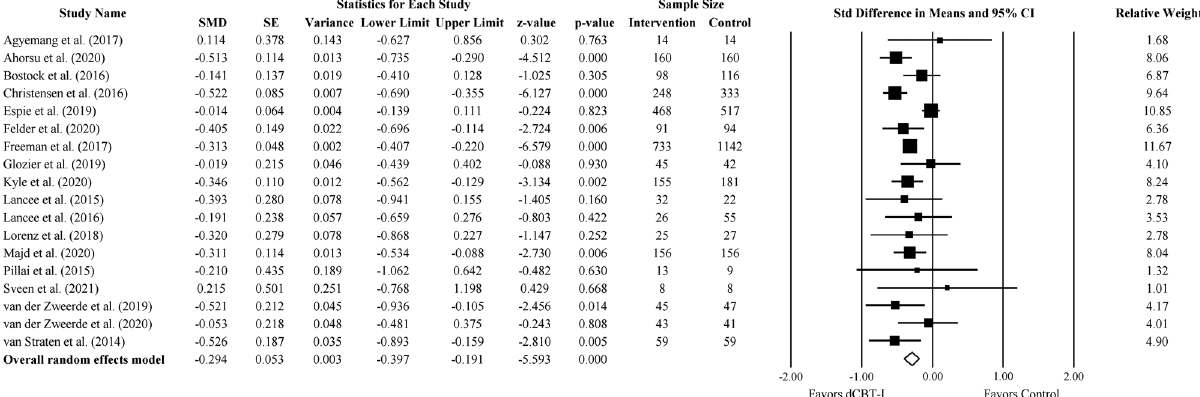
Fig. 3 The effect of dCBT-I on anxiety. Forest plot of studies reporting the effect of dCBT-I on